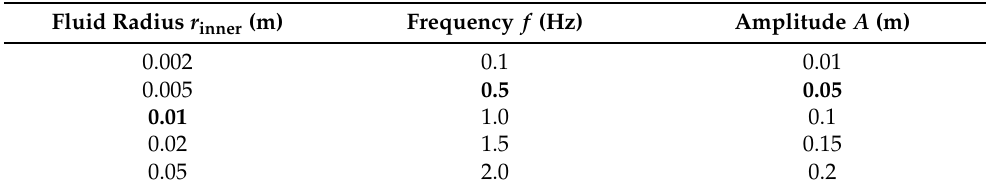
Table 1. Overview of the varied input variables. Marked in bold are the values that are kept constant while varying the other variables.